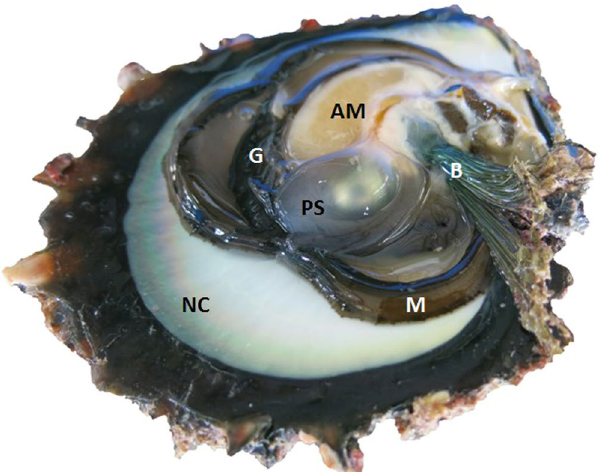
Figure 1. Recipient pearl oyster from Pinctada margaritifera with one shell valve removed showing the general anatomy and the cultured pearl inside the chimera organ, the pearl sac: AM, adductor muscle; NC, nacreous zone; G, gills; B, byssus; M, mantle; and PS, pearl